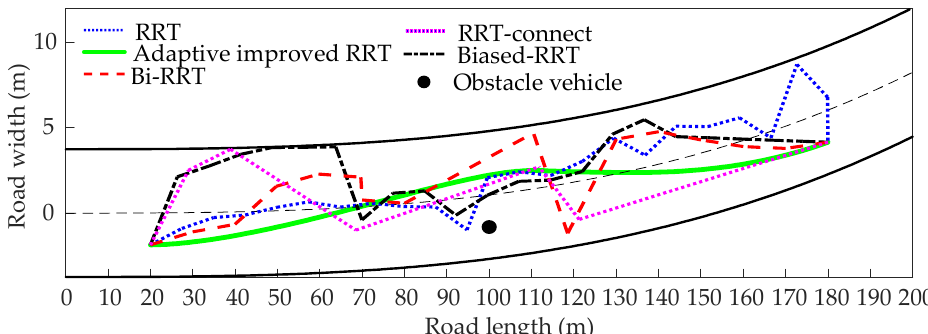
Figure 10. Performance contrast in curved road environment.